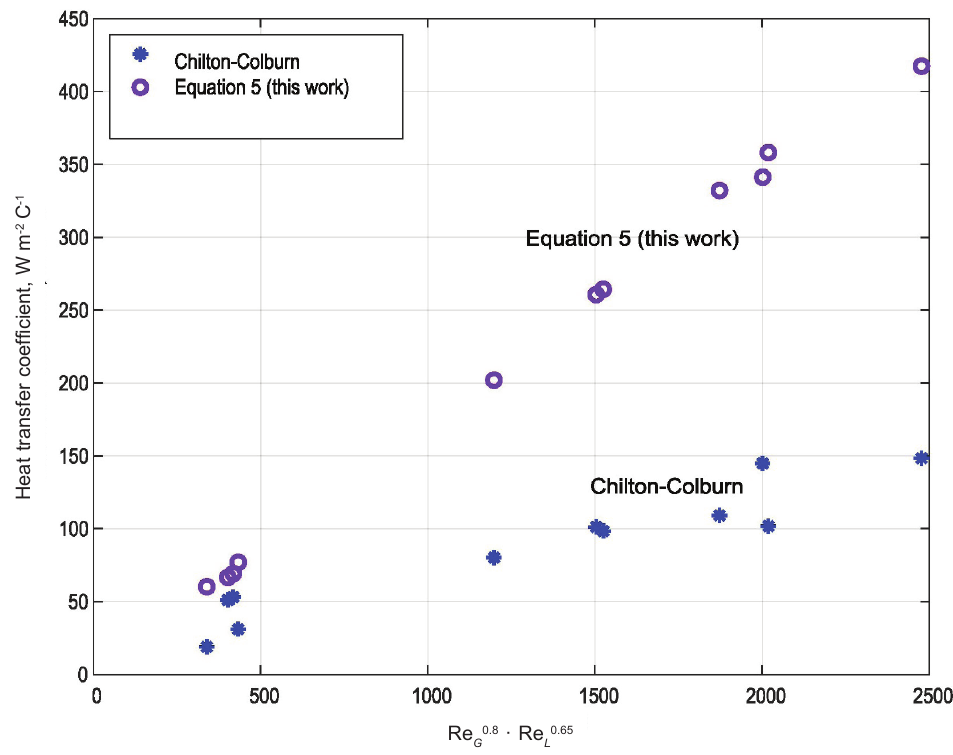
Fig. 9 – Heat transfer coefficient values: This work (Equation 5) versus Chilton – Colburn